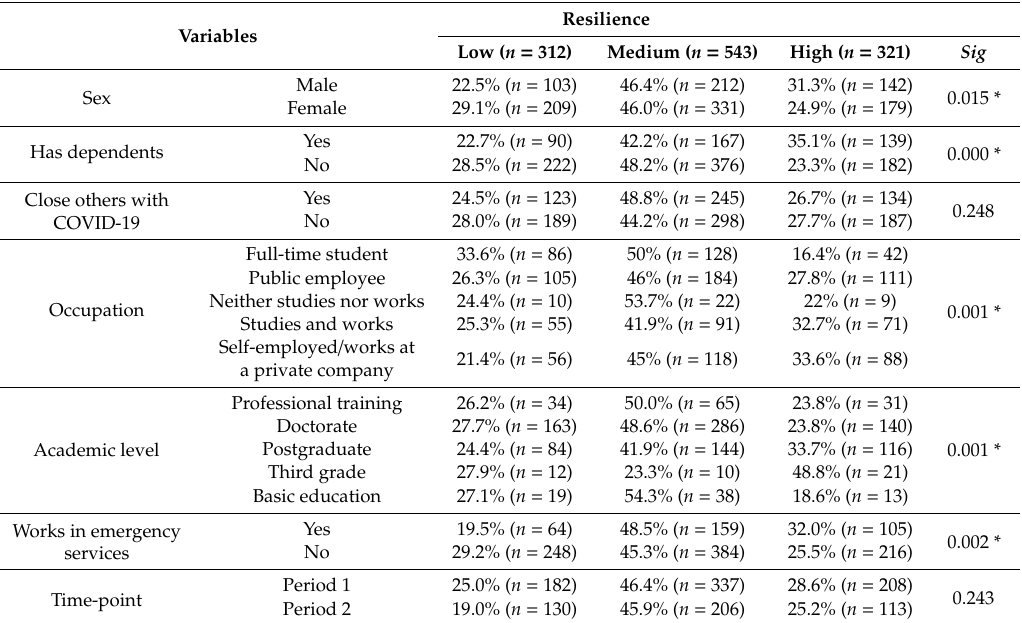
Table 2. Associations between resilience and all other variables.